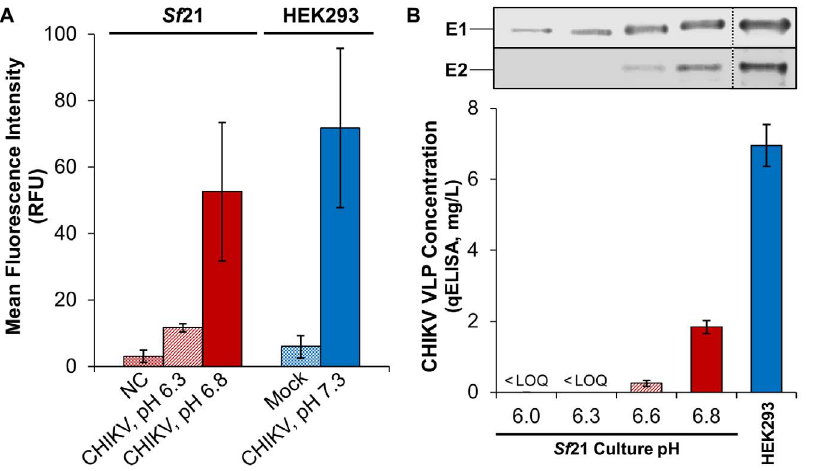
Figure 3. Effect of elevated culture pH on cell-surface localization of CHIKV glycoproteins and CHIKV VLP yield. ( A ) Mean fluorescence intensity (MFI) from surface staining of AcMNPV-CHIKV37997 infected Sf 21 and pV1JNS-CHIKV37997 transfected HEK293 cells with neutralizing antibody m242. AcMNPV-NC and a mock transfection were included as negative controls for Sf 21 and HEK293, respectively. Error bars represent 95% confidence intervals (N=3 independent infections/transfections). ( B ) E1/E2 Western blot and VLP concentration for supernatants from infected Sf 21 and transfected HEK293. Error bars represent 95% confidence intervals (N=4 assay replicates). , LOQ indicates a result less than the qELISA limit of quantitation, or , 2